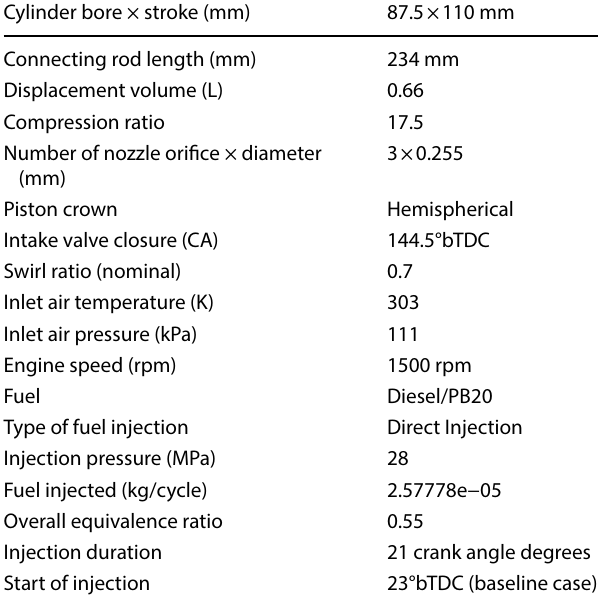
Table 1 Specifications of VCR engine